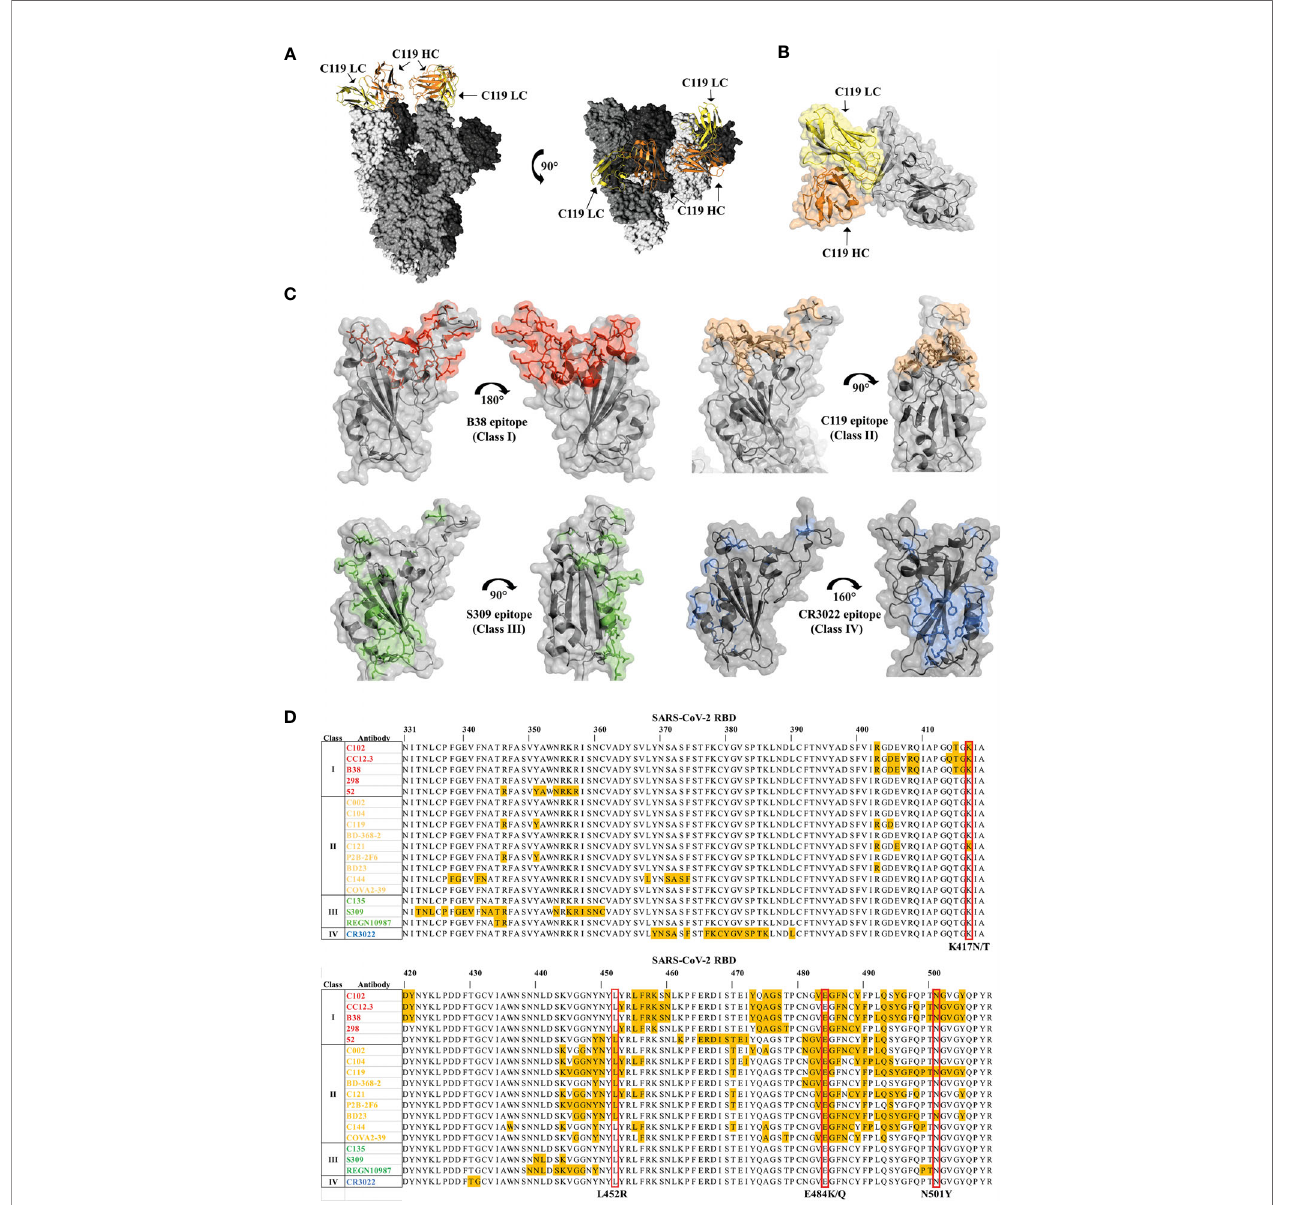
FIGURE 5 | Association of neutralizing antibodies (nAbs) to RBD and mutations of variants B.1.1.7, B.1.351, P.1 and B.1.617 (A) General structure of the interaction of the nAb C119 blocking the binding site of ACE2 in RBD (PDB: 7K8W). (B) Interaction surface of the C119 antibody blocking the ACE2 binding site in RBD (PDB: 7K8W). (C) Regions in RBD that interact with nAbs of different classes. Class I: B38 Antibody (PDB: 7BZ5) (Red), C119 Antibody (PDB: 7K8W) (Sand), S309 Antibody (PDB: 7BEP) (Green), CR3022 Antibody (PDB: 6W41) (Blue). (D) RBD residues (yellow) interacting with class I, II, III and IV nAbs. The mutated